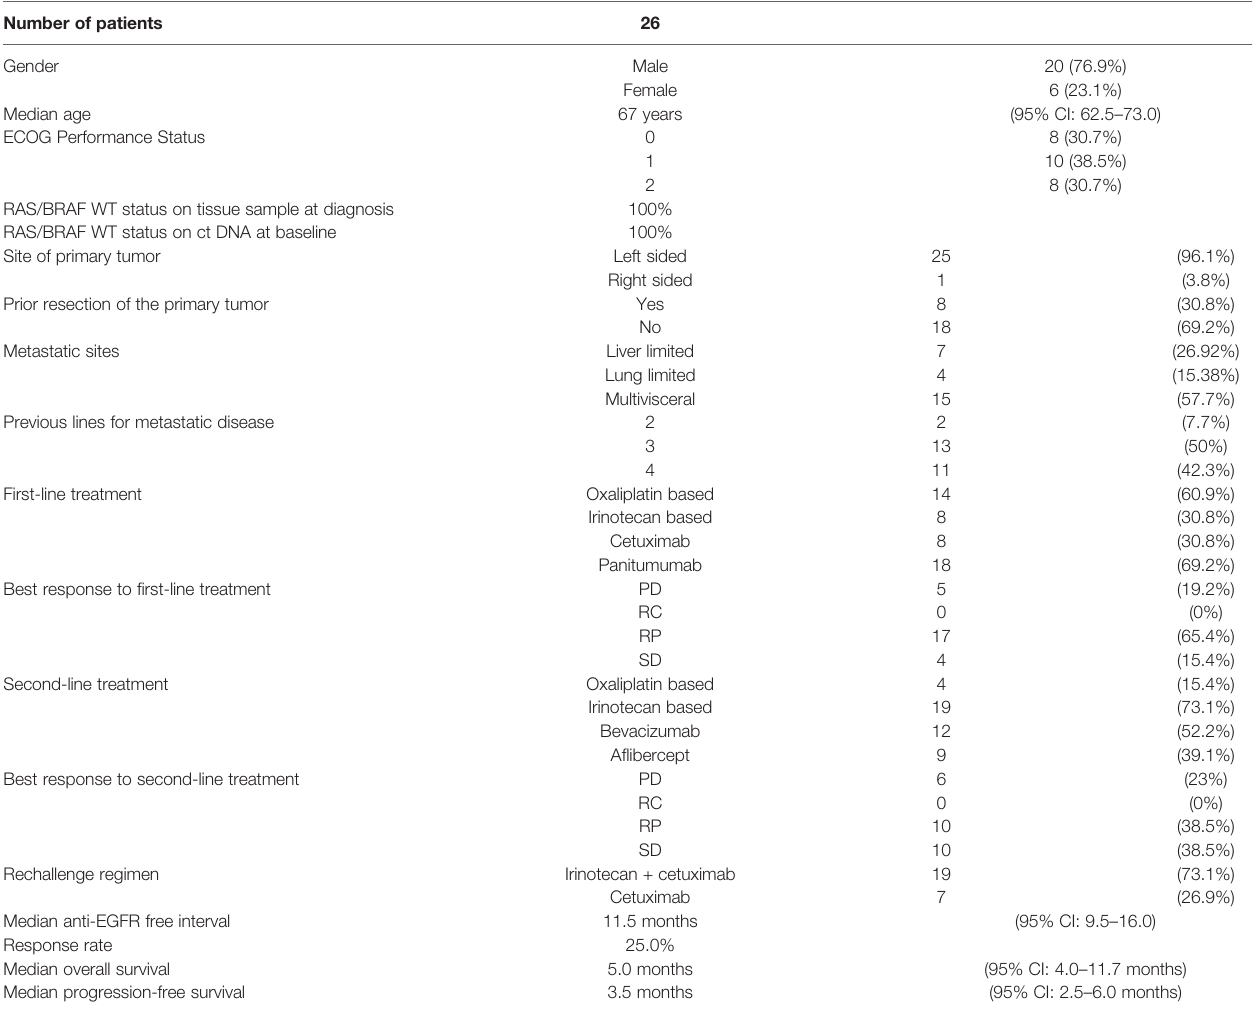
TABLE 1 | Overall clinical and pathological